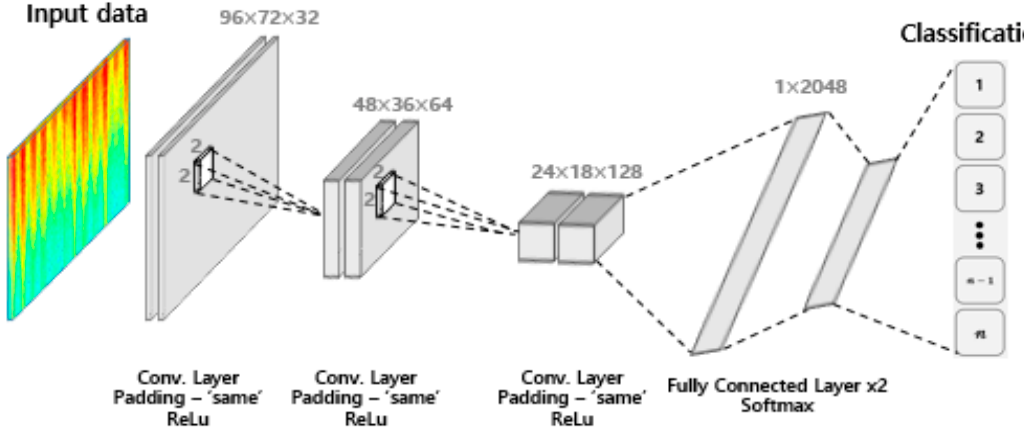
Figure 10. CNN structure.